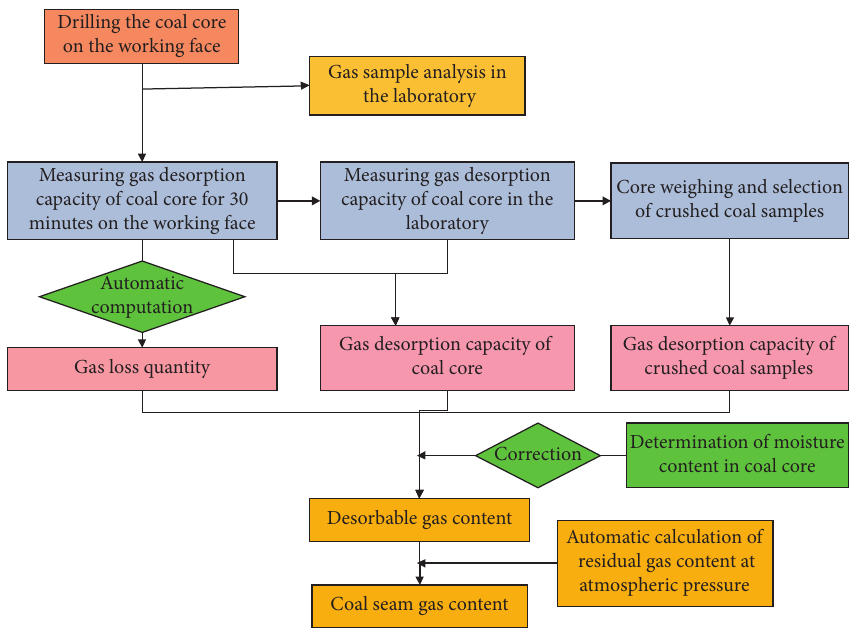
Figure 10: Gas content determination process.